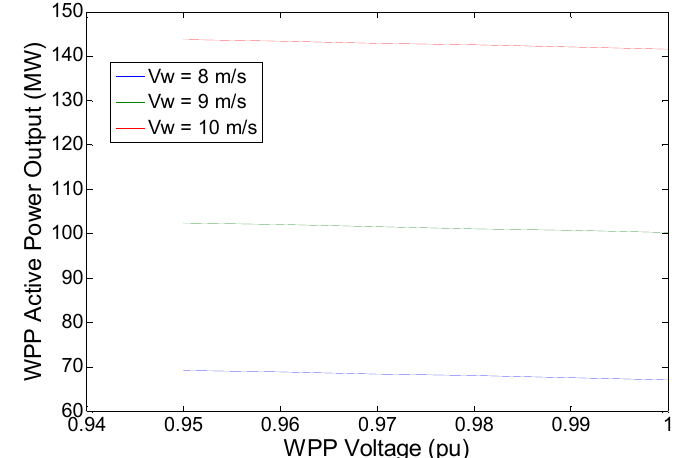
Figure 12. Variation of DFIG stator power.